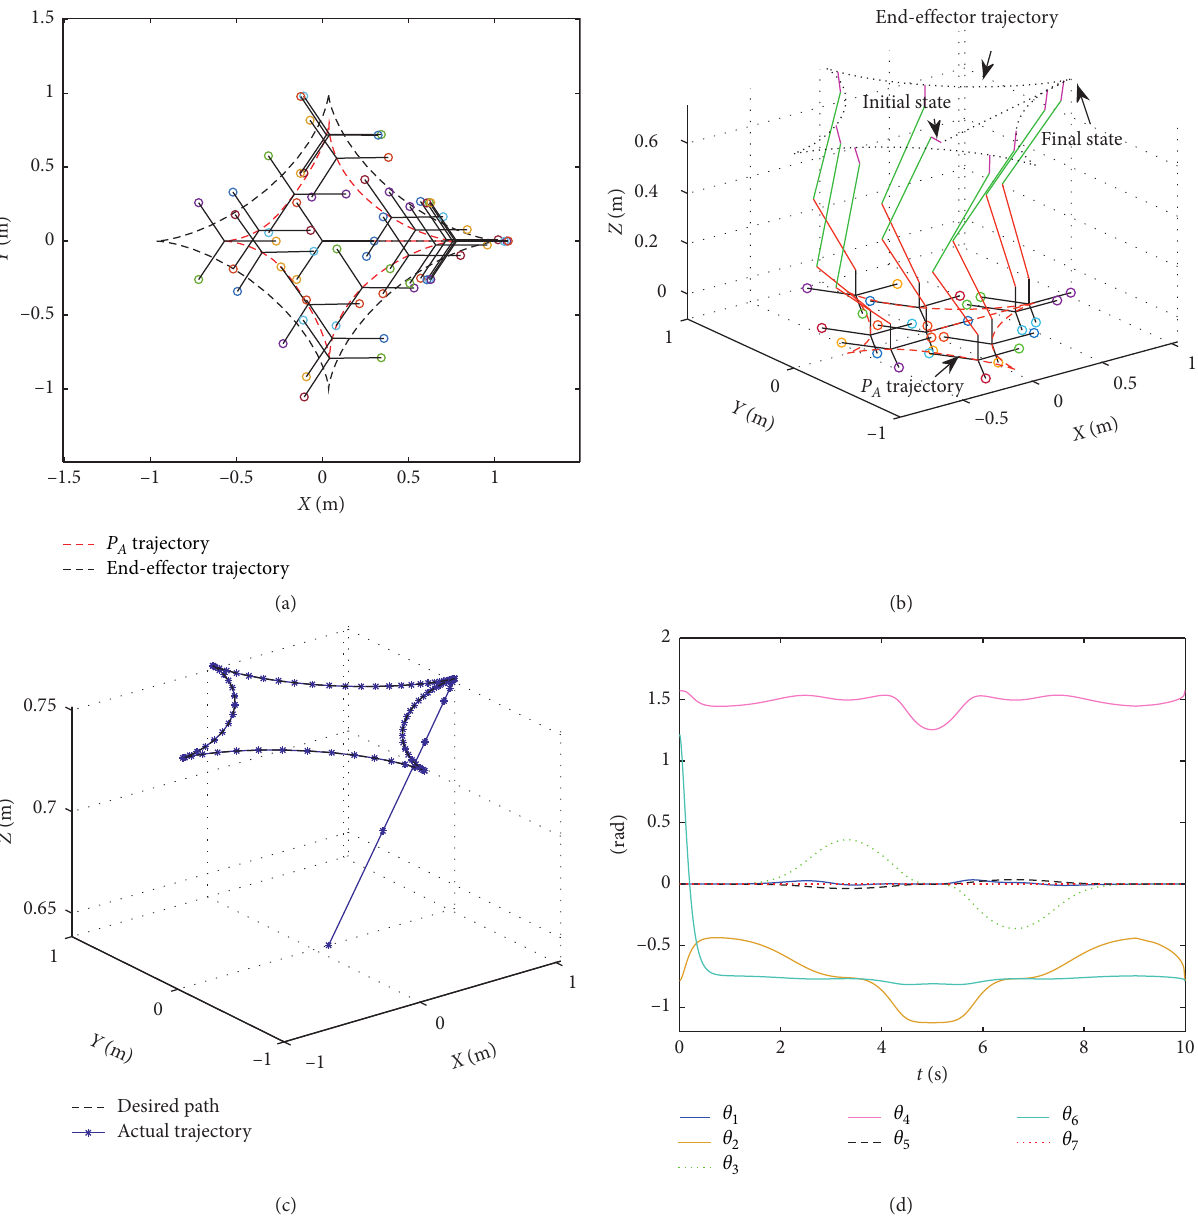
Figure 3: Simulation results of EVPNN model (23) without noise when the end effector of the PA10 mobile robot tracks the star-shaped path. (a) Top view of trajectories of the end effector and platform with three wheels. (b) Horizontal view for the entire mobile manipulator. (c) Desired path and actual trajectory. (d) Profiles of joint angles θ